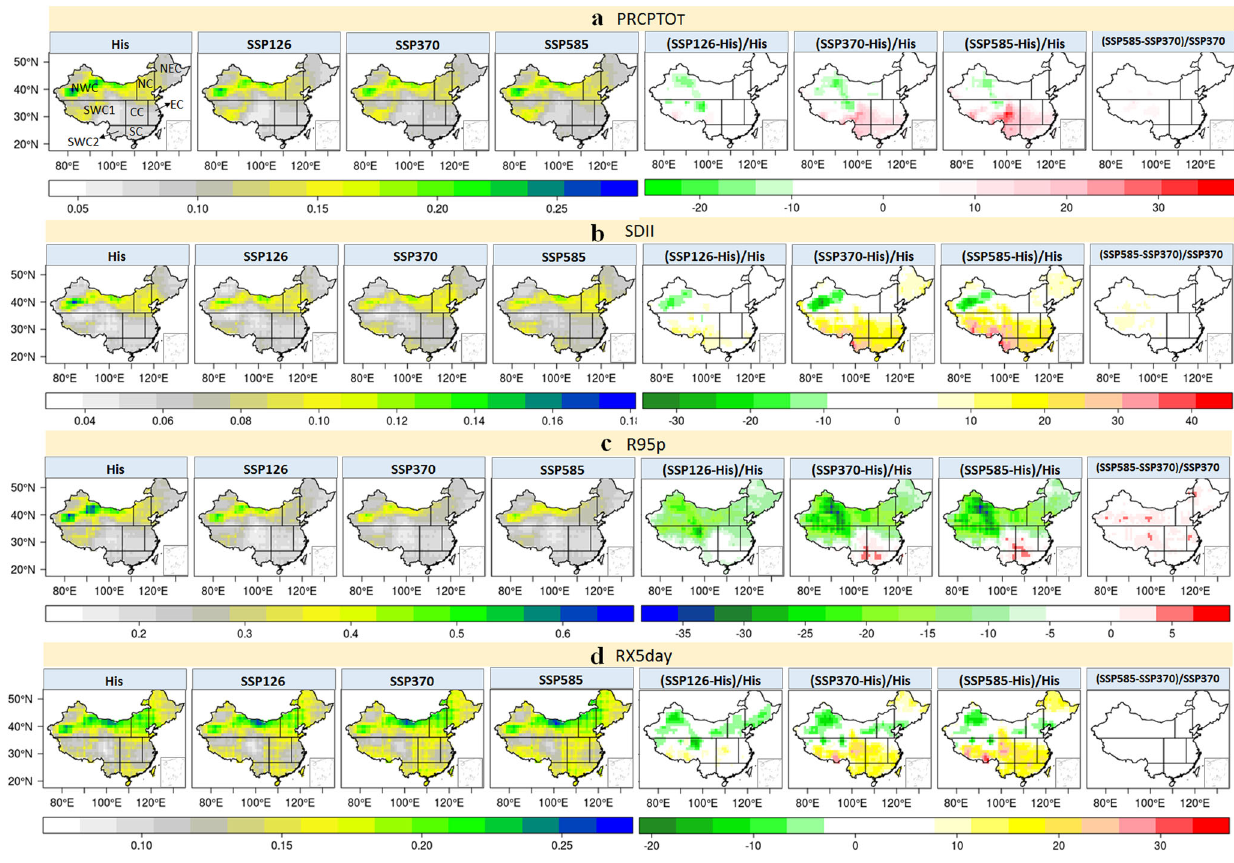
Fig. 4 Comparison of Gini-coef fi cients between historical and future simulations. Comparison between historical simulations (1961 – 2005) and future simulations (SSP126, SSP370, and SSP585, from 2051 to 2095) Gini-coef fi cients for a PRCPTOT, b SDII, c R95p, and d RX5day. The sub fi gures were done in the software R 4.0.2 (https://cran.r-project.org/bin/windows/), and then the sub fi gures were merged by using the Microsoft PowerPoint 2013 software